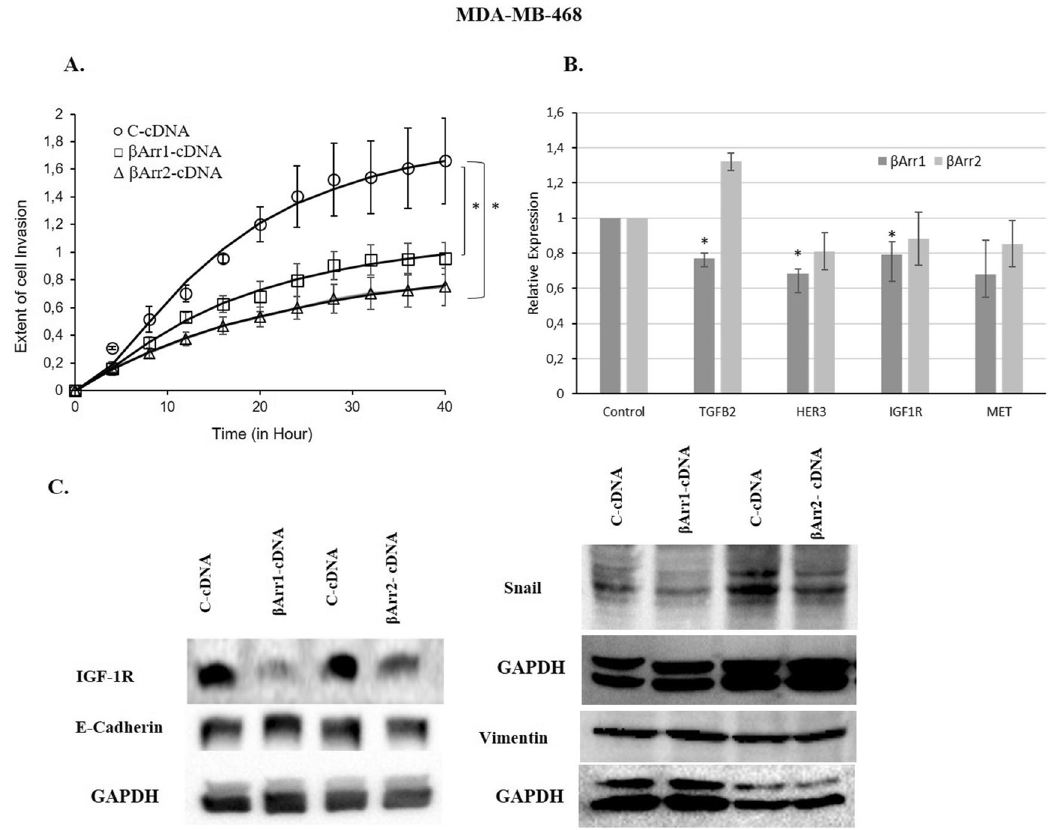
Figure 9. Overexpression of βArr1 or βArr2 and decreased cell invasion in MDA-MB-468. The invasion was significantly reduced in βArr1- or βArr2-cDNA transfected MDA-MB-468 cells. ( A ) Invasion of C (control- cDNA)-, βArr1- or βArr2-cDNA transfected MDA-MB-468 cells was monitored continuously using an xCelligence Real-Time Cell Analyzer in Matrigel coated CIM-plates. The cells were seeded in the upper chamber of the plates and cell invasion dependent changes in impedance were recorded at 40 h. Y axis shows changes in impedance as a measurement of extent of cell invasion. Data are presented as mean ± standard error of the mean; n = 4–5; * = p < 0.05 versus C-cDNA. ( B ) The expression profiles of selected motility and invasion related genes were determined by qRT-PCR experiments and expression of TGFβ2, HER3, IGF1R was significantly downregulated in βArr1-cDNA transfected MDA-MB-468 cells. Data are presented as mean ± standard error of the mean (* p < 0.05 versus C-cDNA). ( C ) In MDA-MB-468, transfection of βArr1 or βArr2-cDNA significantly increased their expression in protein levels, decreased IGF-1R and Snail expression but did not change Cadherin and Vimentin